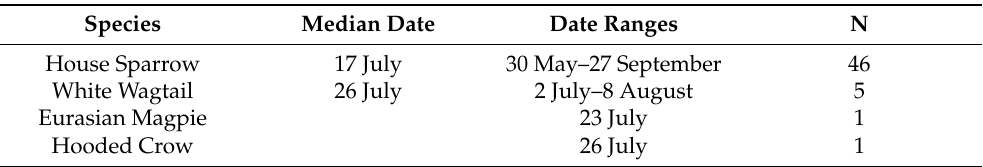
Table 2. Median and range dates of the foraging observations of different bird species on the front panels of cars in Finland, 1971–2022. Note that the “N” for the Eurasian Magpie and the Hooded Crow is only